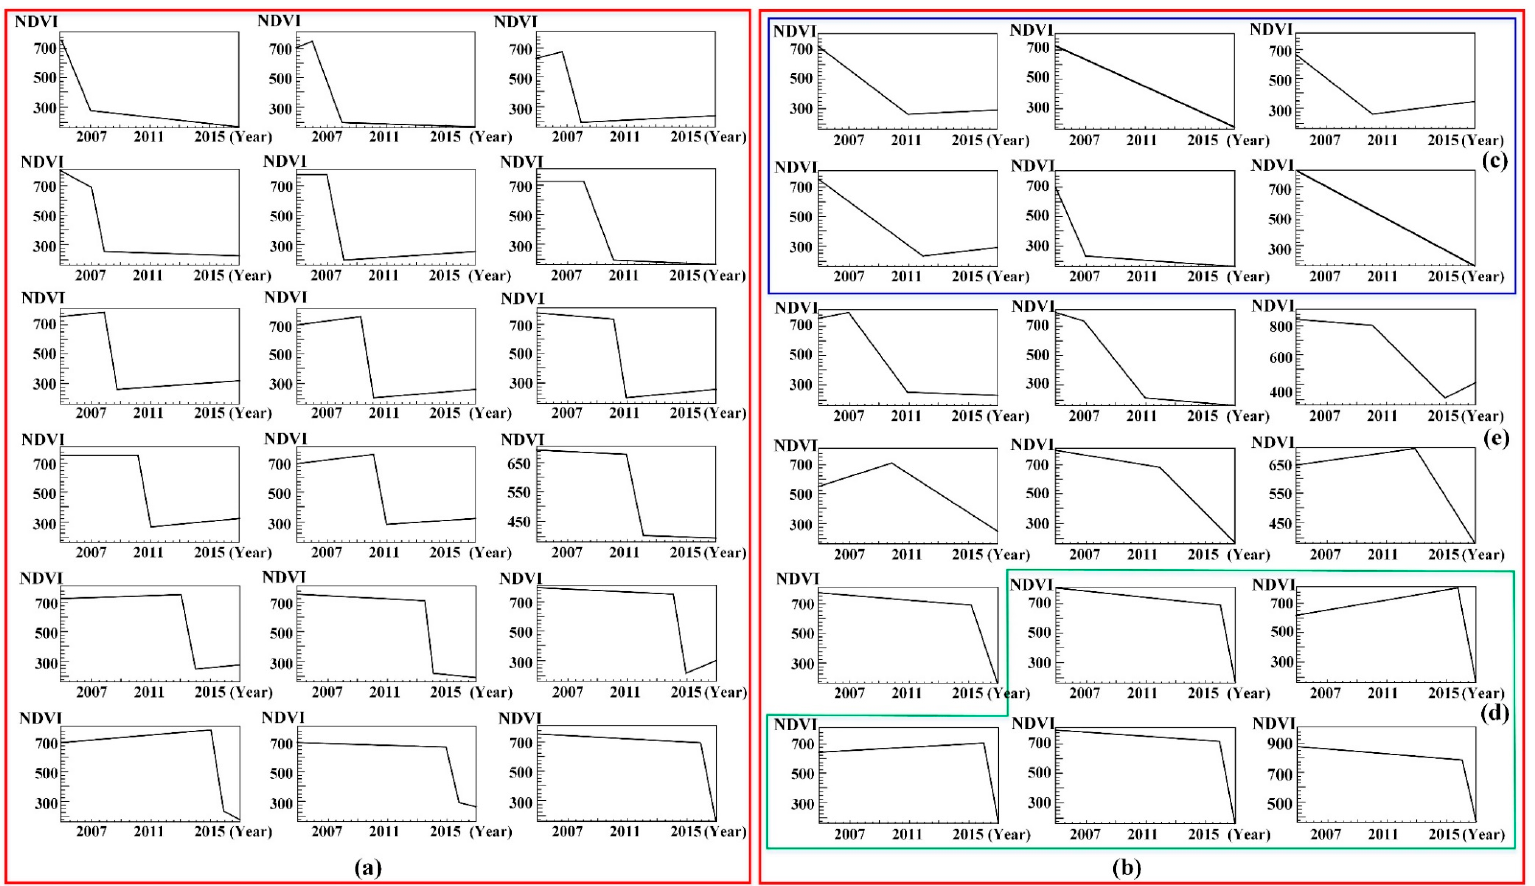
Figure 13. Trajectories of partial verification samples. Trajectories of samples with the time ( a ) correctly and ( b ) incorrectly monitored and trajectories of samples for which the monitoring result was incorrect in ( c ) 2006, ( d ) 2017, and ( e ) other years.